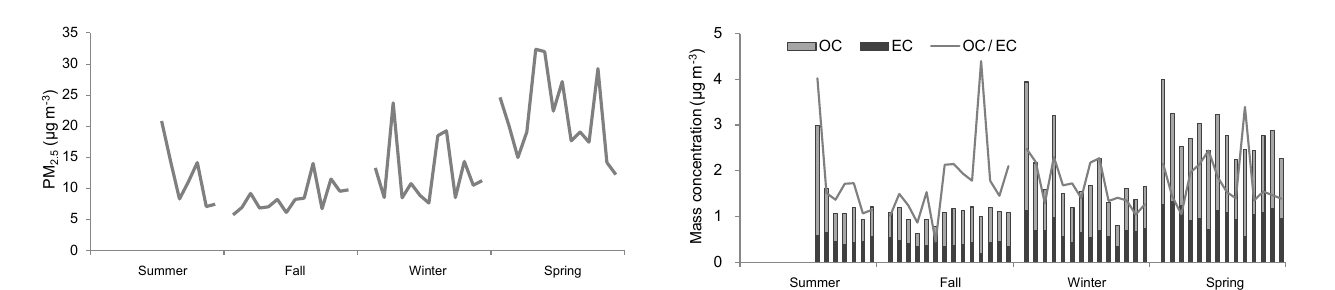
Figure 4. Daily elemental carbon (EC) and organic carbon (OC) mass concentration and OC / EC